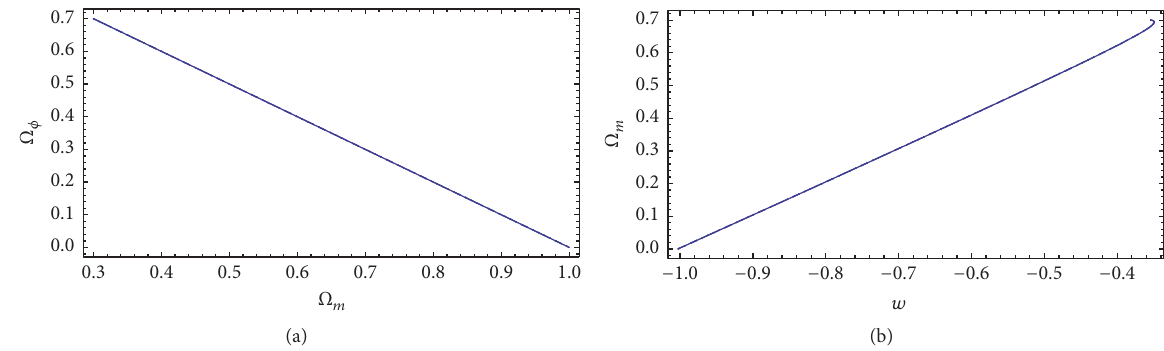
Figure11:Variation ofthedensityparameter ofthephantom quintessencefield asafunction ofthedensity parameterof thedustcosmological matter (a) and of the parameter 𝑤 of the total equation of state (b) for different values of 𝛼 : 𝛼 = 0.8 (solid curve), 𝛼 = 1 (dotted curve), 𝛼 = 1.2 (dashed curve), and 𝛼 = 1.4 (dashed dotted curve), respectively.